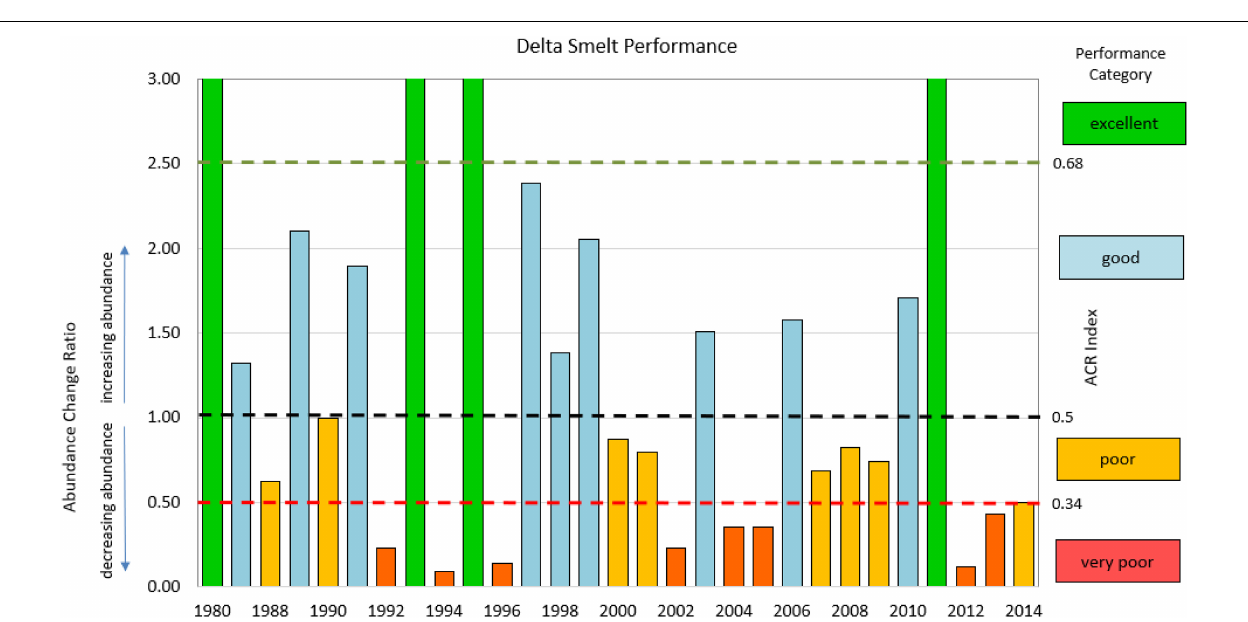
FIGURE 3 | Abundance Change Ratio (ACR) for 1987 through 2014 identified by performance categories for delta smelt of excellent, good, poor, and very poor. Note that the Y-axis is truncated at 3.0. The years with excellent performance all have ACR values exceeding 6. Although no survey was conducted in 1979, 1980 is included because of its relation to abundance in